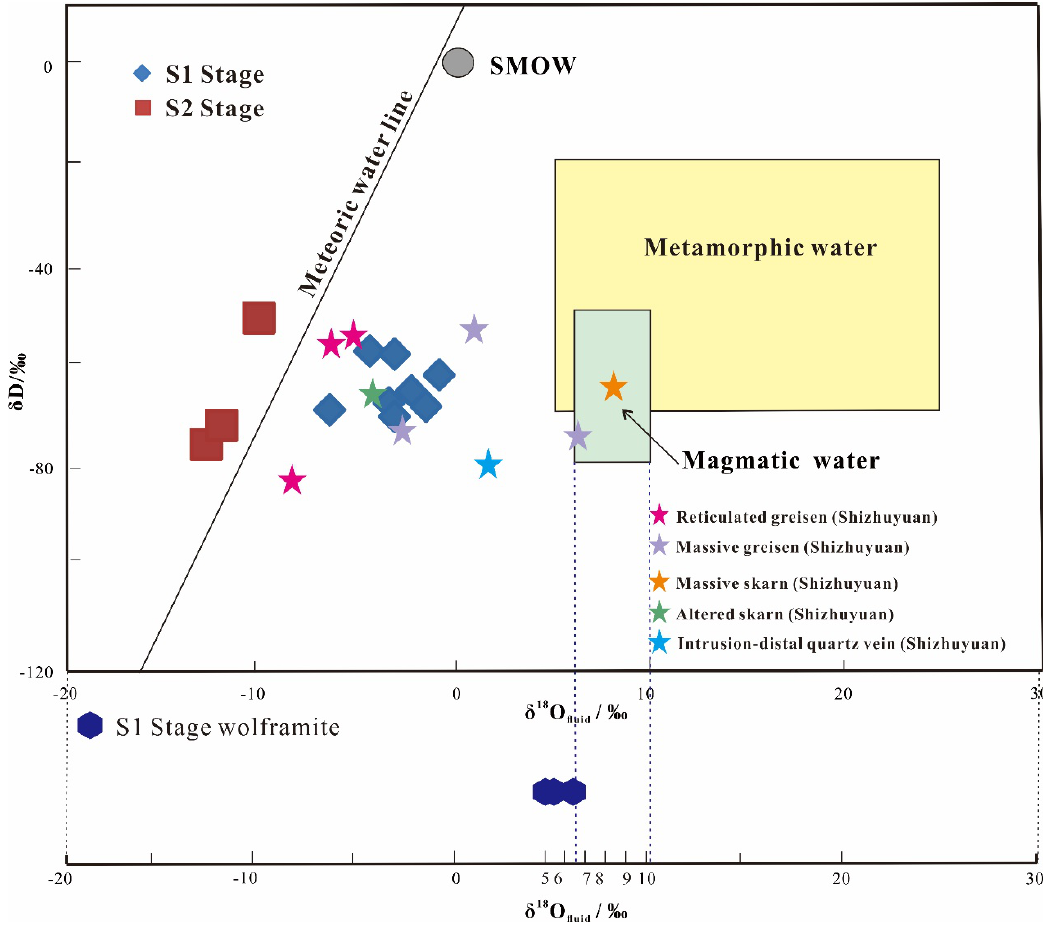
Figure 11. The plot of δ 18 O- δ D shows the calculated fluid composition of quartz veins in different stages. The primary magmatic water field, metamorphic water field, and meteoric water line are from [56]. SMOW = Standard Mean Ocean Water. Table 3. Oxygen isotope data and the calculated fluid isotope compositions of the Hongqiling Sn-W polymetallic deposit.